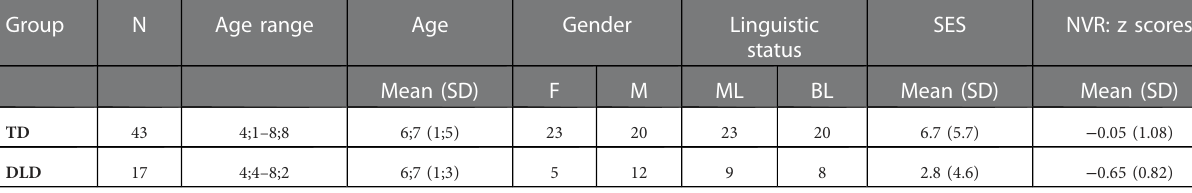
TABLE 1 Demographics characteristics and scores on NVR task of the sample, by group. Group N Age range Age